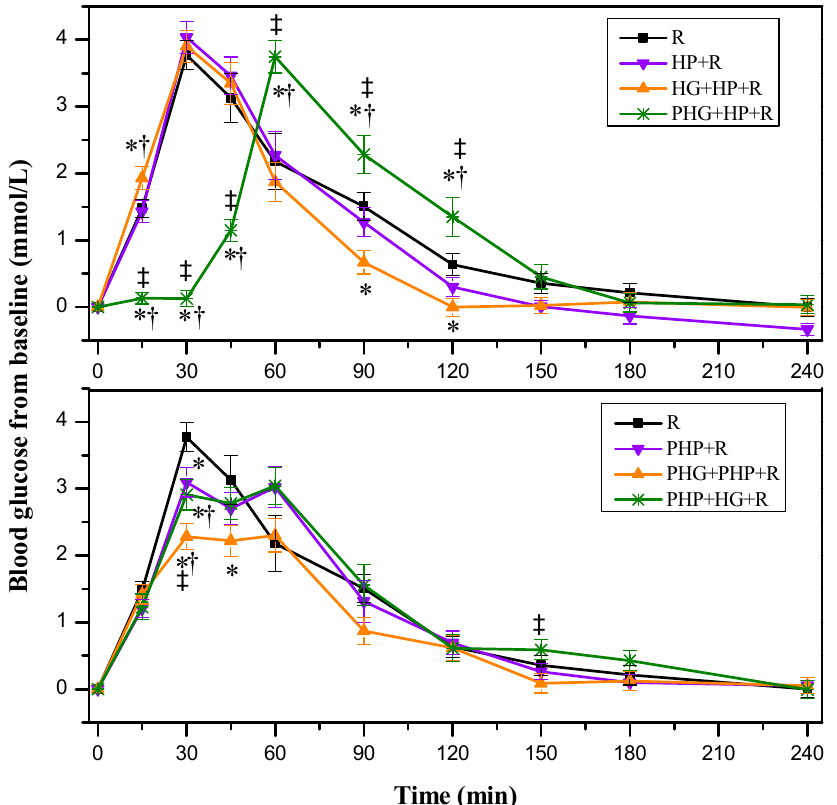
Figure 4. Blood glucose changes from baseline for mixed test foods (n = 17). R, rice; HP, highly cooked potato; PHP, preload HP; HG, partially hydrolyzed guar gum; PHG, preload HG; HP + R, co-ingestion of HP and rice; HG + HP + R, co-ingestion of HG, HP, and rice; PHG + HP + R, preload HG 30 min prior to co-ingestion of HP and rice; PHP + R, preload HP 30 min prior to rice; PHG + PHP + R, co-preload HG and HP 30 min prior to rice; PHP + HG + R, preload HP 30 min prior to co-ingestion of HG and rice. Values are shown as the mean value with their standard errors represented by vertical bars. * Test meals different from rice, † HG containing meal different from HP + R or PHP + R; ‡ HG preload meal different from HG post-ingested meal ( p < 0.05).